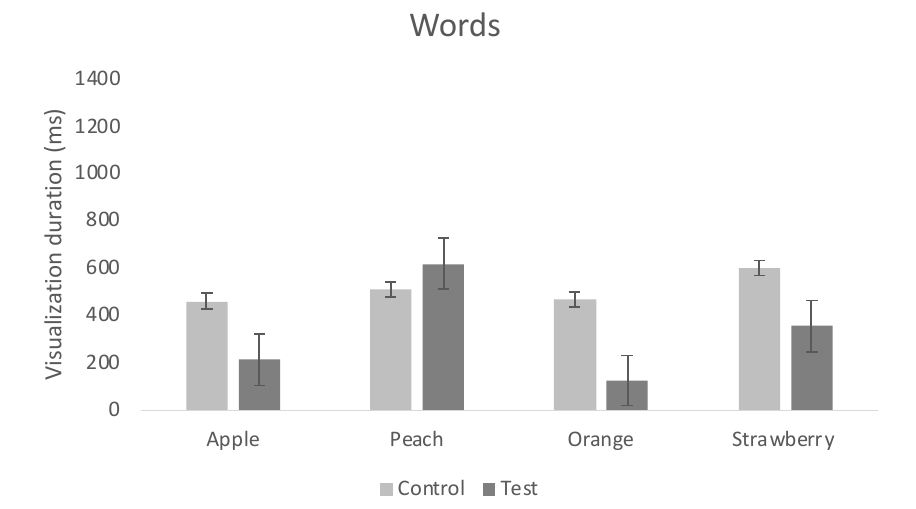
FIGURE 6 – Dwell time for different words of fruits (apple, peach, orange, and strawberry) before applying the fragrances (control) and after administering the olfactory stimulus